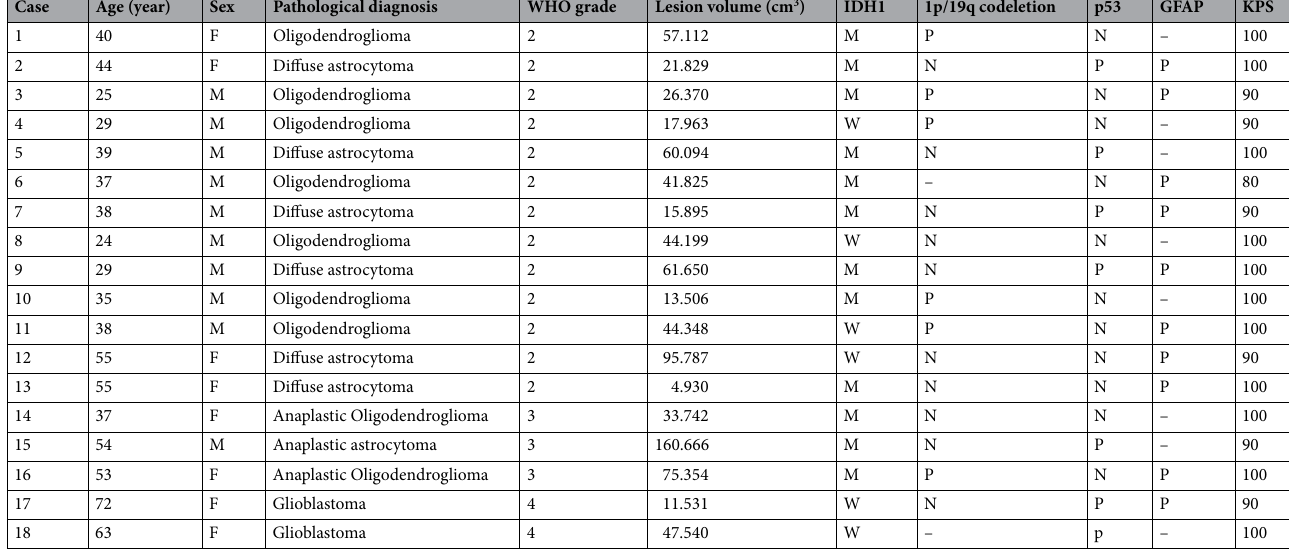
Table 1. Characteristics and Karnofsky performance status scores of patients with left frontal gliomas. Sex: F female, M male, WHO World Health Organization, IDH isocitrate dehydrogenase, M mutant, W wildtype;